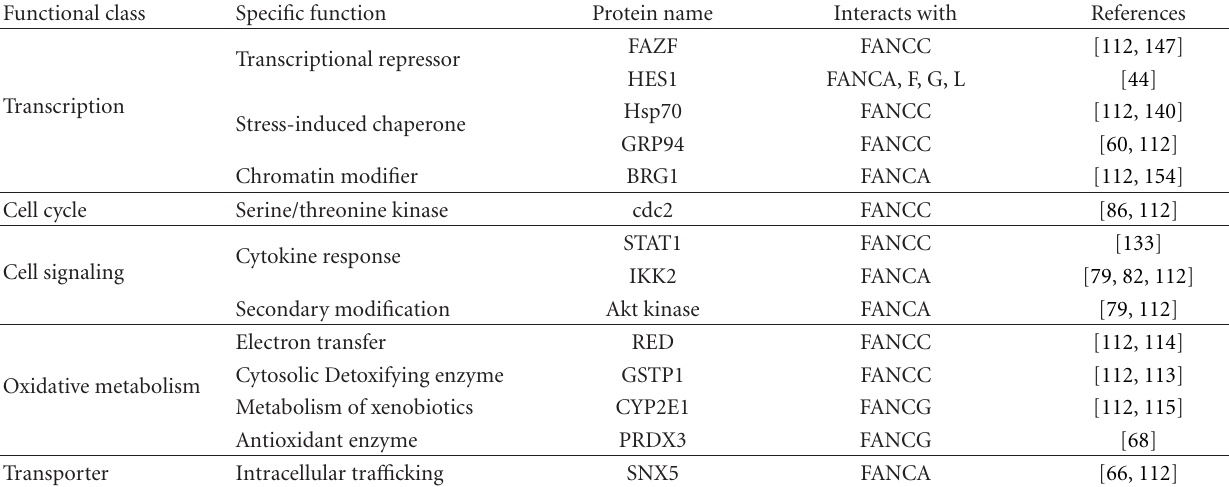
Table 1: List of FA protein